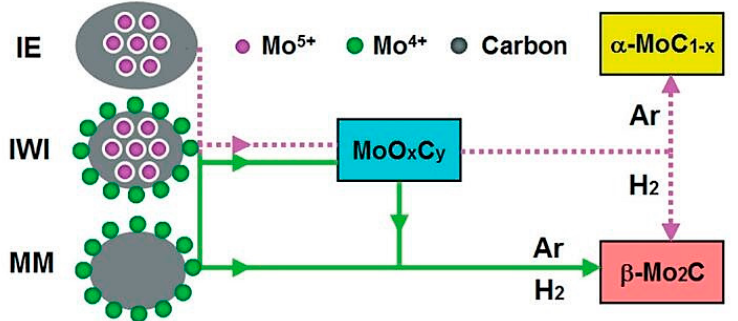
Figure 4. Schematic illustrating the reaction pathways during the carburization of different Mo oxide precursors in Ar or H 2 gas reproduced from reference [72] with permission from The Royal Society of Chemistry.